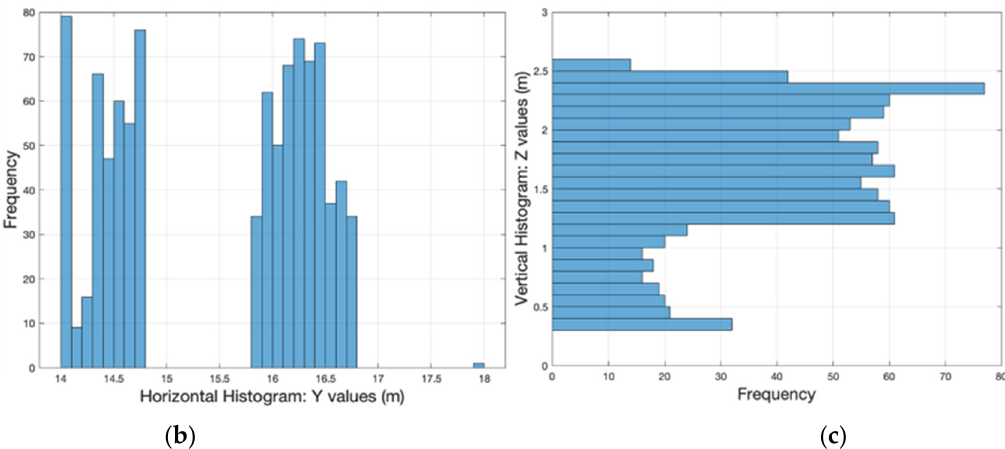
Figure 7. Door and window candidates: ( a ) extracted points representing two window features, ( b ) horizontal density histogram, and ( c ) vertical density histogram.